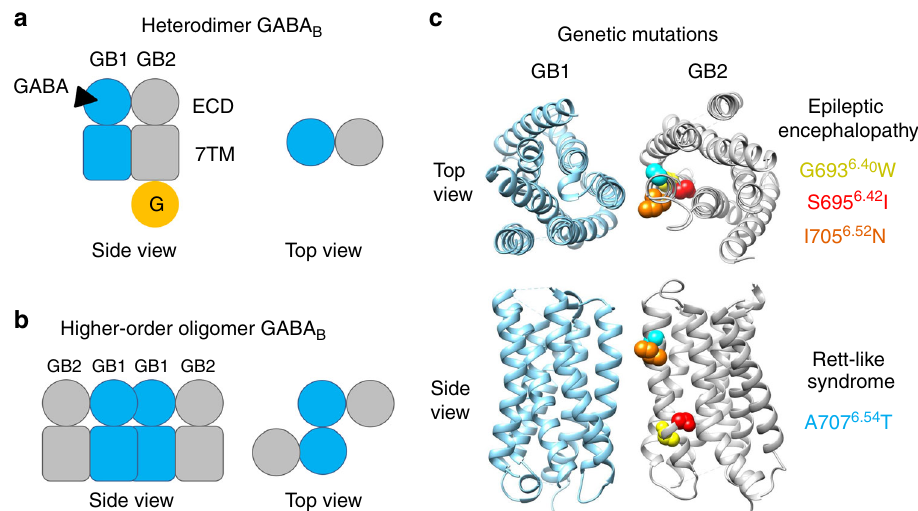
Fig. 1 Schematic representation of the GABA B receptor. a GABA B forms an obligatory heterodimer made of the two subunits GABA B1 (GB1, blue) and GABA B2 (GB2, grey). GABA binds to the extracellular domain (ECD) of GB1, while the GB2 heptahelical domain (7TM) is responsible for G-protein activation. b GABA B has the tendency to form stable higher-order hetero-oligomers that are likely organized through interactions between the GB1 subunits, while GB2 is likely not directly involved in these contacts. c Recently reported loss-of-function genetic mutations in GB2 7TM in human diseases. Most of these mutations affect residues in GB2 TM6 (Gly693, yellow; Ser695, red; Ile705, orange; Ala707, cyan). These mutations produce a constitutively active receptor, except the mutation of Gly693 that has not been studied in functional